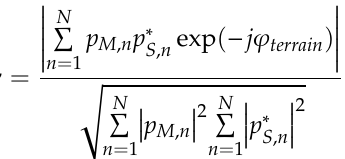
Figure 10. Comparison of the correlation coefficient distribution obtained by different methods. P o i n t s N u m .